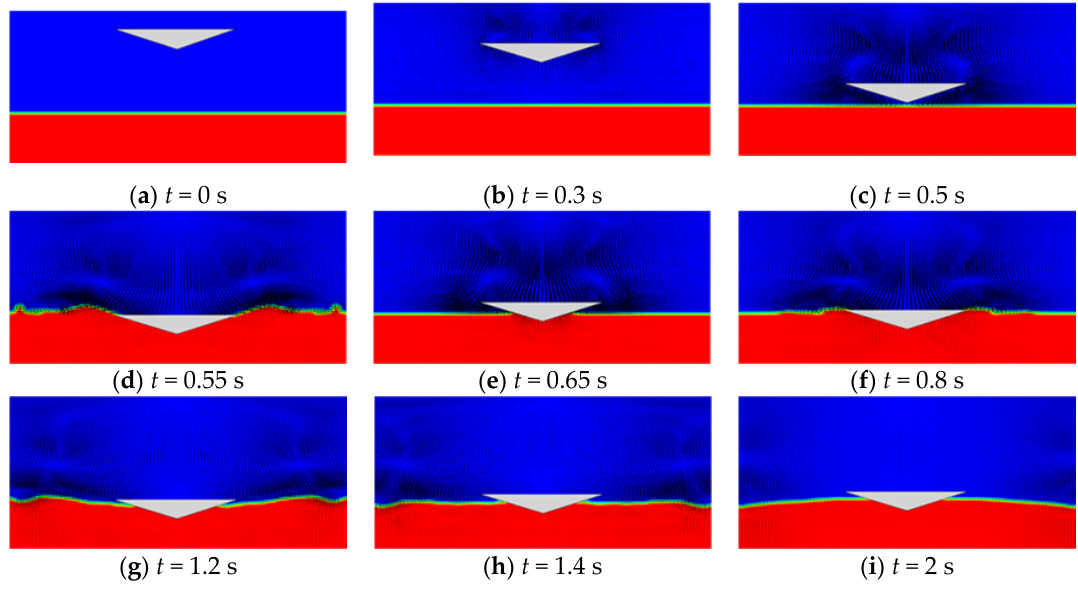
Figure 18. Velocity vector of free-falling wedge; the contour shows the density distribution of two-phase at different times: ( a ) t = 0 s; ( b ) t = 0.3 s; ( c ) t = 0.5 s; ( d ) t = 0.55 s; ( e ) t = 0.65 s; ( f ) t = 0.8 s; ( g ) t = 1.2 s; ( h ) t = 1.4 s; ( i ) t = 2